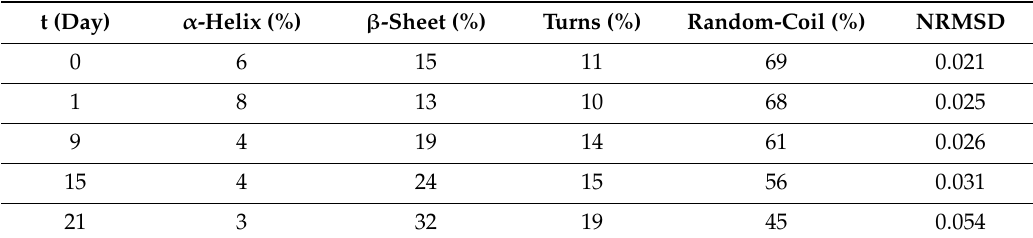
Figure 2. TEM images of salmon calcitonin aggregates typical of the three phases: “Lag-phase” (T1; A ), “Growth-phase” (T13; B ) and “Saturation-phase” (T20; C ) together with the corresponding SEC profiles (elution fractions vs. absorbance at λ = 280 nm). The protein configuration percentages obtained by circular dichroism spectroscopy, were also reported ( D – F ). Table 1. Percentage of the secondary structures obtained by the fitting procedure, relative to CD spectra relative to sCT incubated at 4 ◦ C for increasing times (t; see Figure S1). The normalized root-mean-square deviation (NRMSD) value (last column) represents an estimation of the goodness of fitting procedure (see Section